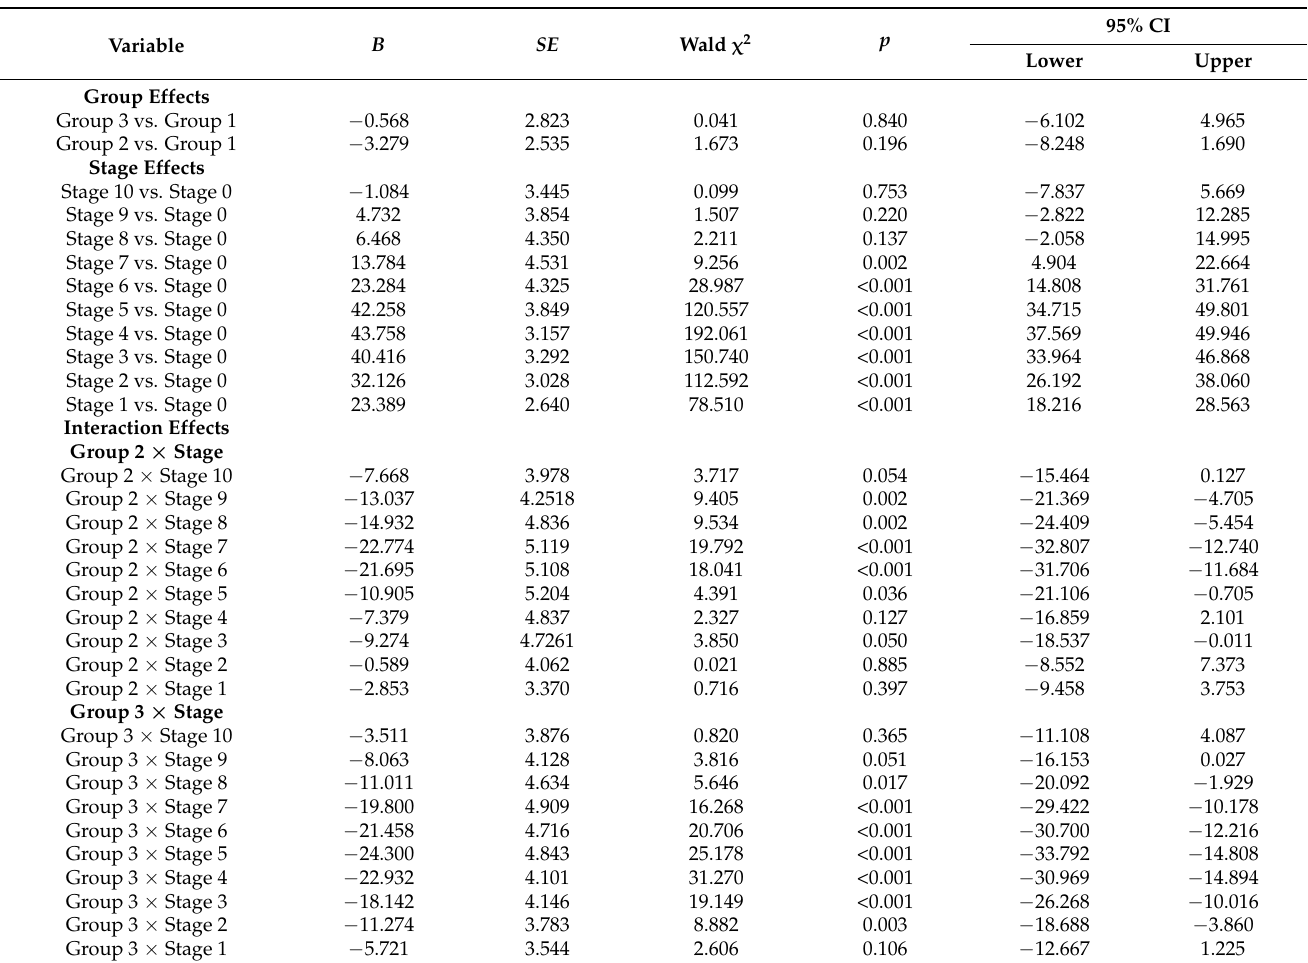
Table 2. Comparison of changes in heart rates among neonates in the three treatment groups across the 11 stages of the heel-prick procedure: Analysis using generalized estimating equation with multiple linear